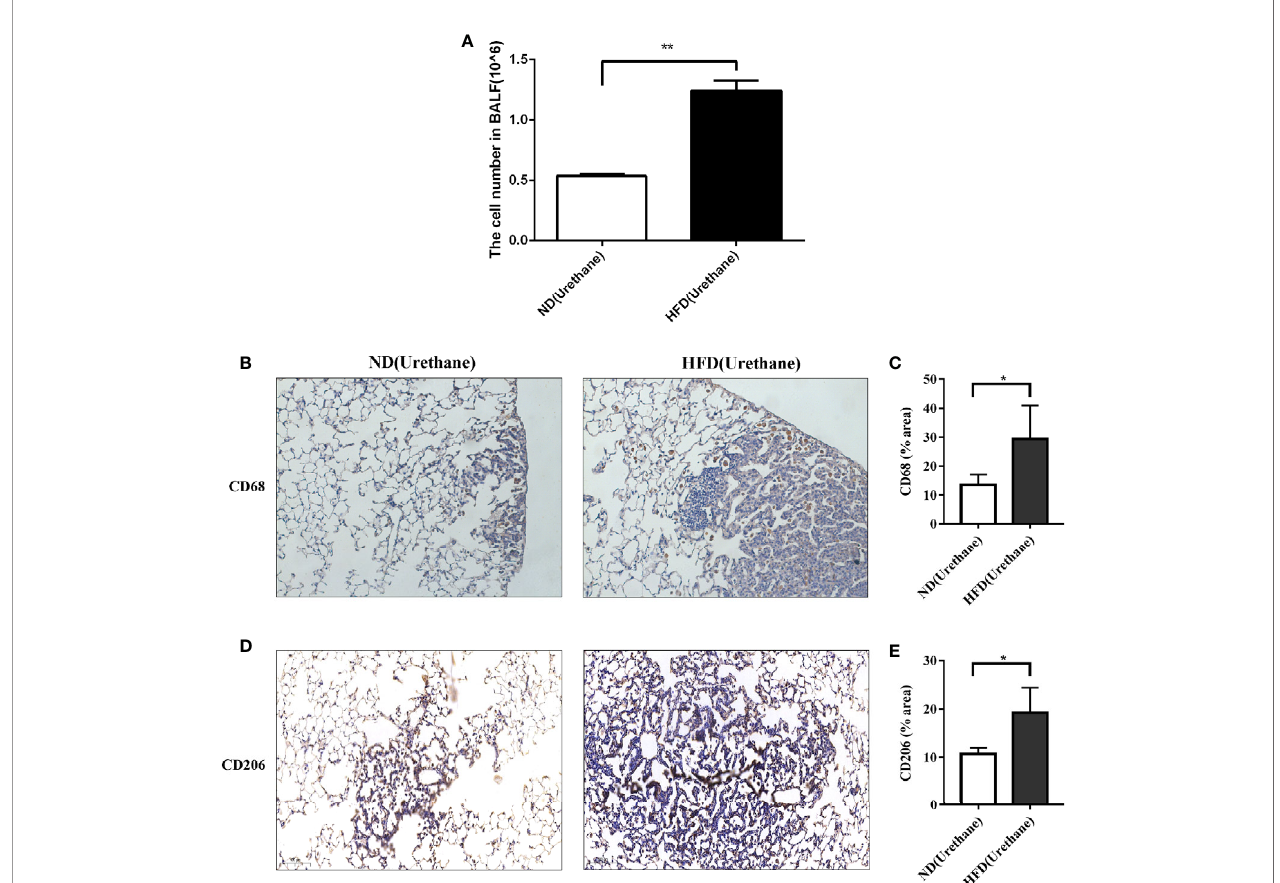
FIGURE 3 | In fi ltration of immune cells in bronchoalveolar lavage fl uids and lung tissue. (A) Increased BALF cell count in urethane treated high-fat diet fed mice compared to urethane treated control diet fed mice (n=3 mice/group). **P < 0.01. (B, C) Increased expression of CD68 in lung tissue of urethane treated HFD-fed mice compared to urethane treated ND-fed mice. (B) Representative images of lung sections in urethane treated mice. Brown dots indicate the CD68 positive macrophages. (Original magni fi cation: ×200). (C) Quanti fi cation analysis of immunohistochemistry related to CD68 between two diet groups by ImageJ. (n=4 mice/ group). *P < 0.05. (D, E) Increased expression of CD206 in lung tissue of urethane treated HFD-fed mice compared to urethane treated ND-fed mice. (D) Representative images of lung sections in urethane treated mice. Brown dots indicate the CD206 positive macrophages. (Original magni fi cation: ×200). (E) Quanti fi cation analysis of immunohistochemistry related to CD206 between two diet groups by ImageJ. (n =4-5 mice/ group). *P <